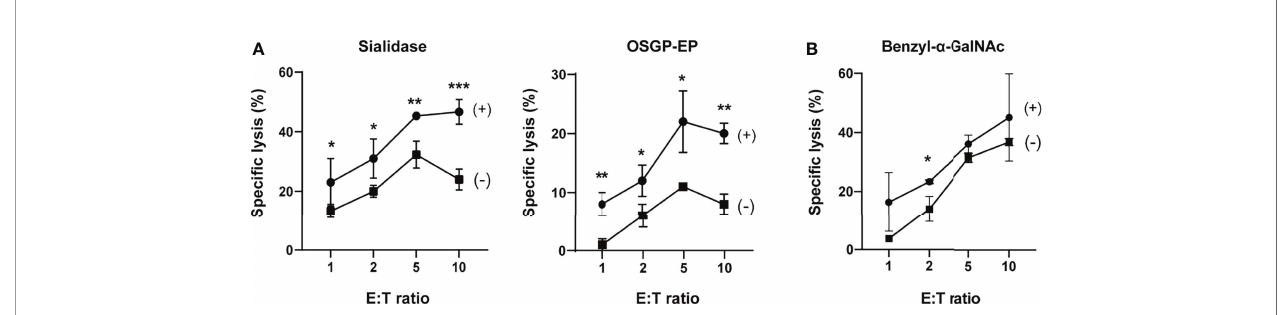
FIGURE 2 | Sialylated O-glycoproteins protect chronic lymphocytic leukemia B cells from NK cell cytotoxicity. (A) Effects of sialidase or O-sialoglycoprotein endopeptidase (OSGP-EP) treatment of JVM-3 cells on NK cell cytotoxicity. JVM-3 cells were treated with sialidase or OSGP-EP and subjected to cytotoxicity assay using an NK-92 cell line expressing Siglec-7 (NK-92MI/S7). Both treatments made JVM-3 cells more sensitive to NK cell cytotoxicity. Cytotoxicity assays were conducted in technical triplicate and repeated several times, with consistent results. Representative results are shown (* P < 0.05, ** P < 0.01, and *** P < 0.001; Student ’ s t test). Bars represent mean ± SD of technical triplicates. (B) Effect of benzyl-2-acetamido-2-deoxy- a - D -galactopyranoside (benzyl- a -GalNAc) treatment of JVM-3 on NK cell cytotoxicity. JVM-3 cells cultured in the presence of benzyl- a -GalNAc (72 h) were more sensitive to NK cell cytotoxicity.